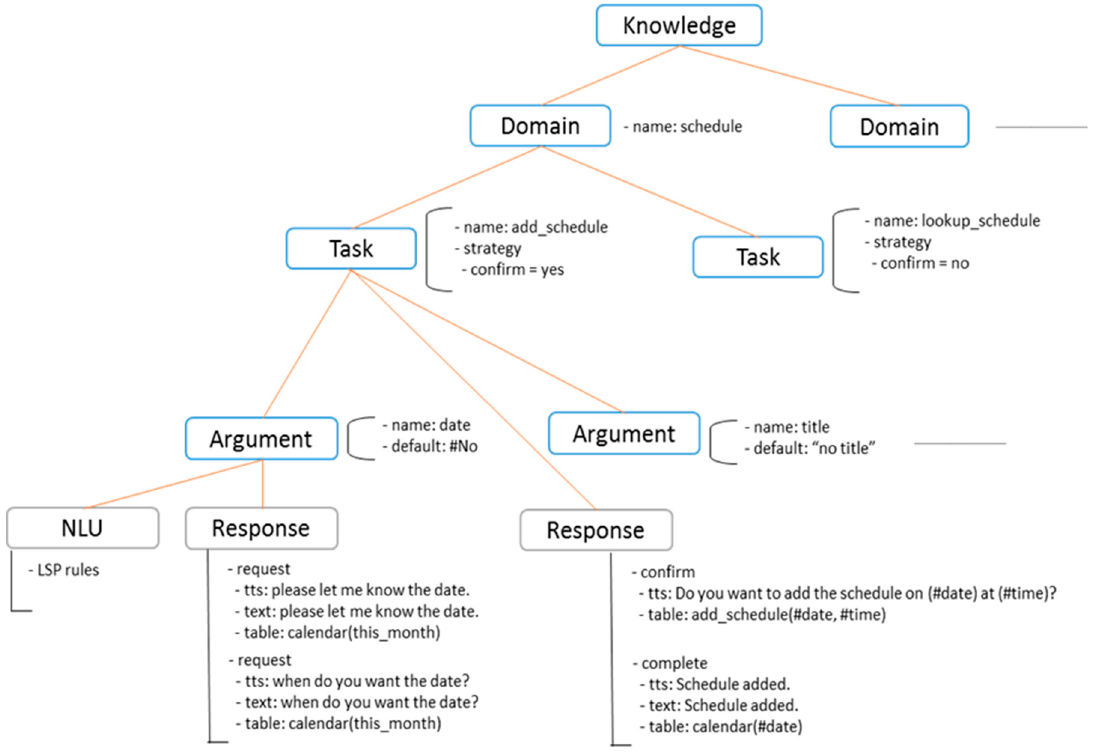
Figure 5. Structure of dialog knowledge.